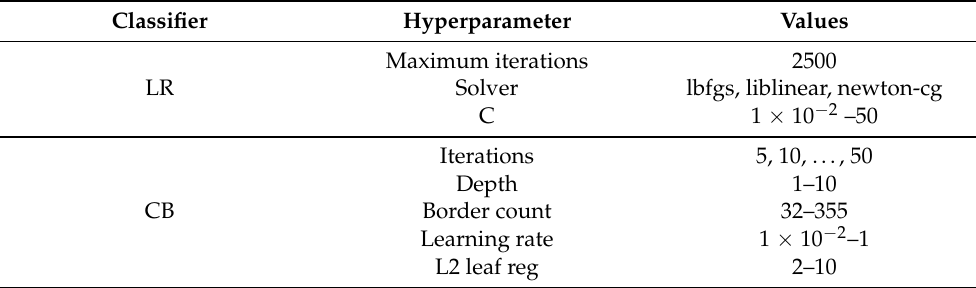
Table 2. The hyperparameter search space in experiments where FFT data was used as